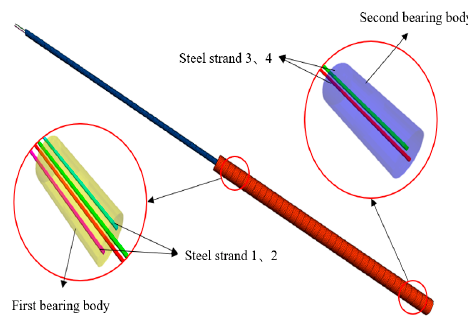
Figure 14. Model details. Table 3. Calculation parameter values.